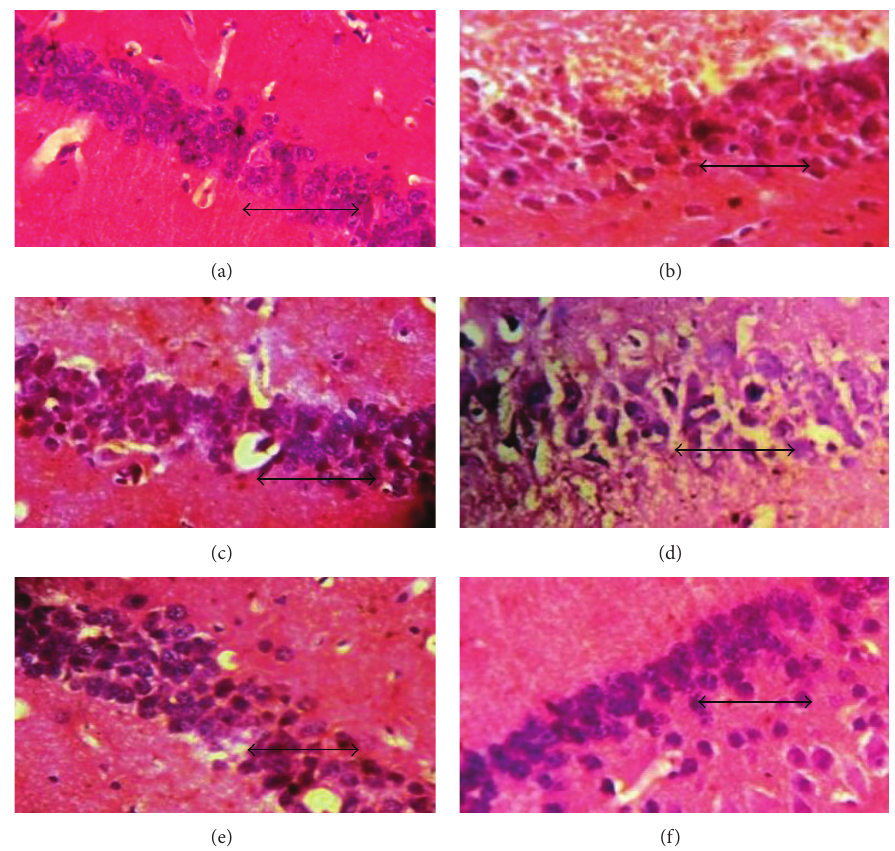
Figure 4: Effect of lisinopril and fosinopril on the morphology of CA1 region of hippocampus in scopolamine-induced amnesic rats. Light photomicrographs of CA1 layer of hippocampus in (a) control rats, (b) scopolamine, (c) lisinopril (0.225 mg/kg) + scop., (d) lisinopril (0.45 mg/kg) + scop., (e) fosinopril (0.90 mg/kg) + scop., and (f) fosinopril (1.80 mg/kg) + scop. Scale bar represents 1 𝜇